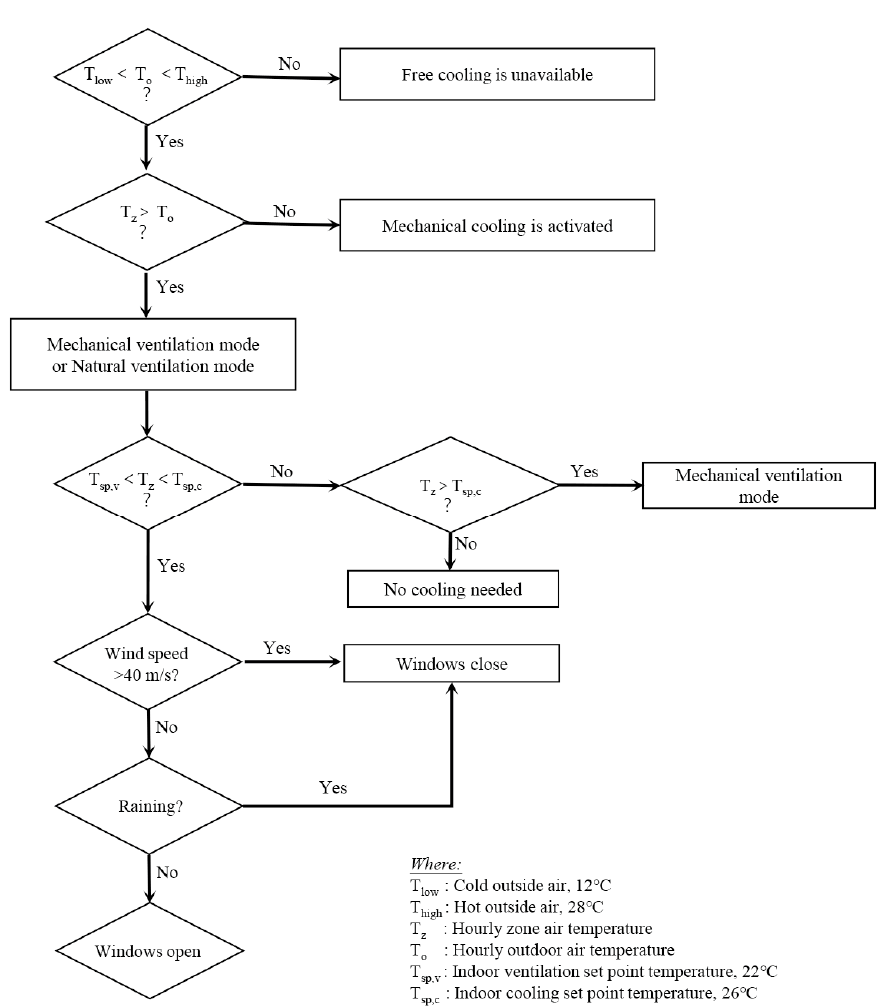
Figure 5. Operation strategies of mixed-mode cooling.